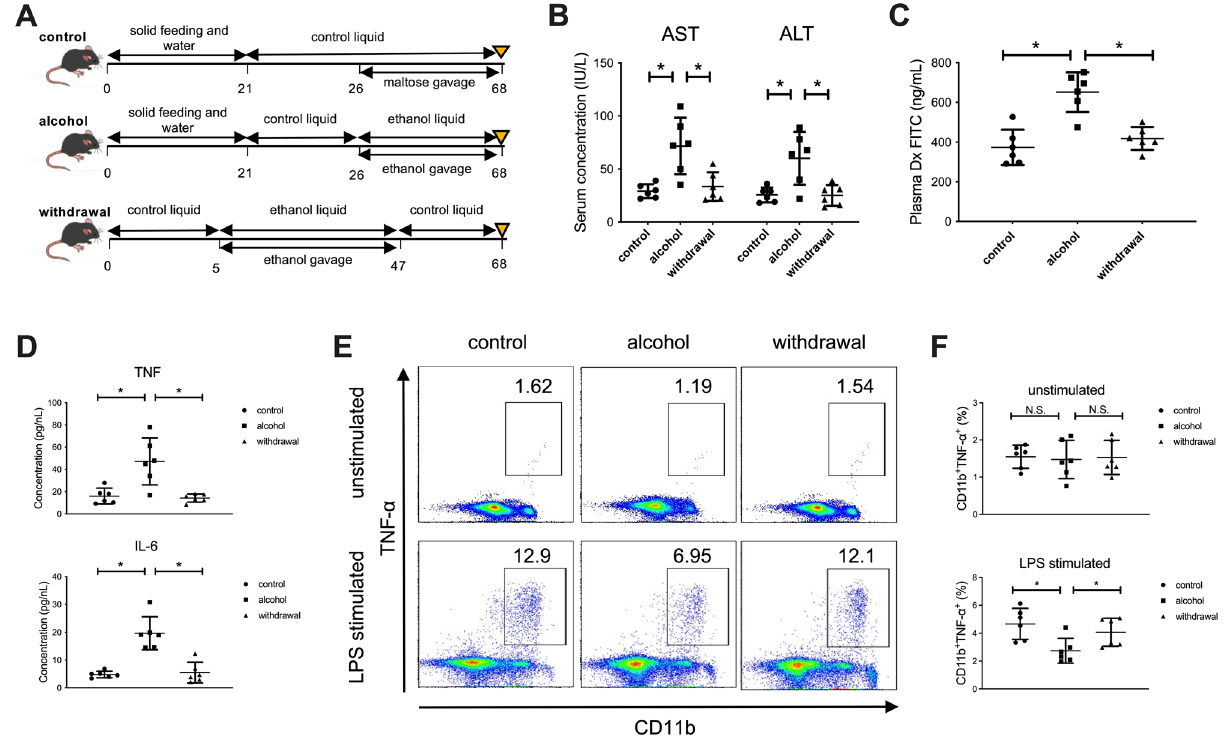
Figure 5. Increased intestinal permeability and the subsequent influx of PAMPs mediated by continuous alcohol administration to mice result in suppressed production of inflammatory cytokines from CD11b + macrophages in the liver. ( A ) Study design. Control mice (n = 6) received a control liquid diet for 26 days. They were gavaged with isocaloric maltose dextrin twice per week for the last 6 weeks. Alcohol-treated mice (n = 6) received the control liquid diet for 5 days and the 5% ethanol liquid diet for 6 weeks. Withdrawal-group mice (n = 6) received the control liquid diet for 5 days and 5% ethanol liquid diet for 6 weeks, followed by feeding with the control liquid diet for 3 weeks as a withdrawal period. ( B ) Serum aspartate aminotransferase (AST) and alanine aminotransferase (ALT) levels. ( C ) Intestinal permeability evaluated by measuring the amount of fluorescence from dextran-FITC (Dx FITC) at 4 h after gavage. ( D ) Serum levels of TNF-α and IL-6. ( E ) Representative surface CD11b and intracellular TNF-α staining of liver mononuclear cells derived from the indicated mice, either unstimulated (upper) or stimulated with LPS for 4 h (lower). ( F ) Frequency of hepatic TNF-α producing CD11b + macrophages from the indicated mice either unstimulated (upper) or stimulated with LPS for 4 h (lower). Data represent the mean ± SD. * p value < 0.05 by one-way ANOVA. N.S.: not significant. Data are representative from three independent Collectively, our findings suggest a previously unrevealed mechanism of how chronic excessive alcohol intake induces immunological tolerance of monocytes. Strikingly, acetaldehyde directly affects the immune response, which is reversible, following alcohol abstinence. Although further investigations with a large cohort validation are needed, the results of this study provide a new perspective on the systemic influence of excessive alcohol consumption according to the genetic polymorphisms of alcohol-metabolizing enzymes in Japanese AD patients.